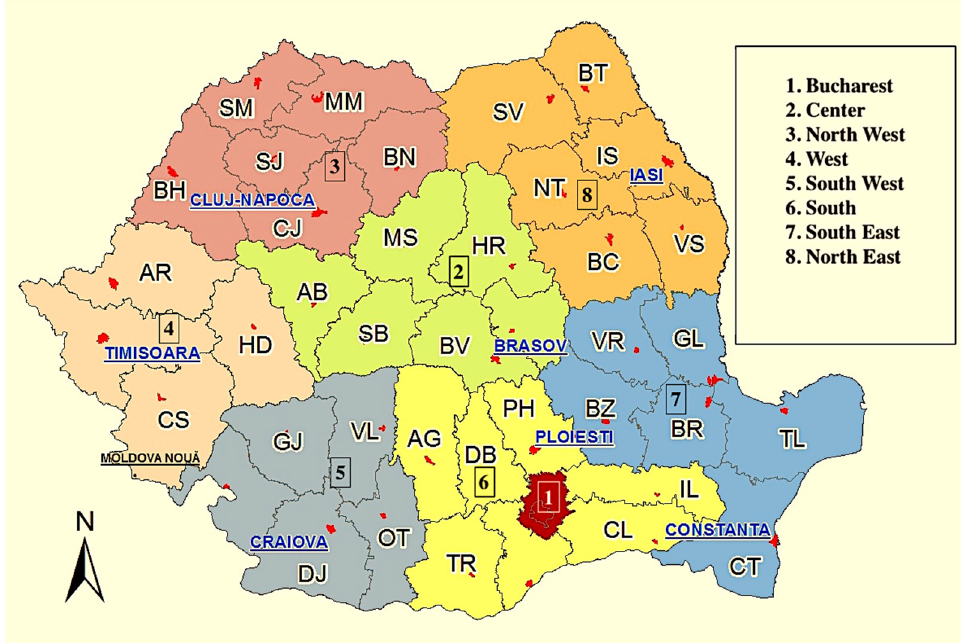
Figure 2. Geographical regions of Romania (adapted figure) . http://www.cniptmoldovanoua.ro/harta-regiuni-romania/ accessed on the 14 March 2023.